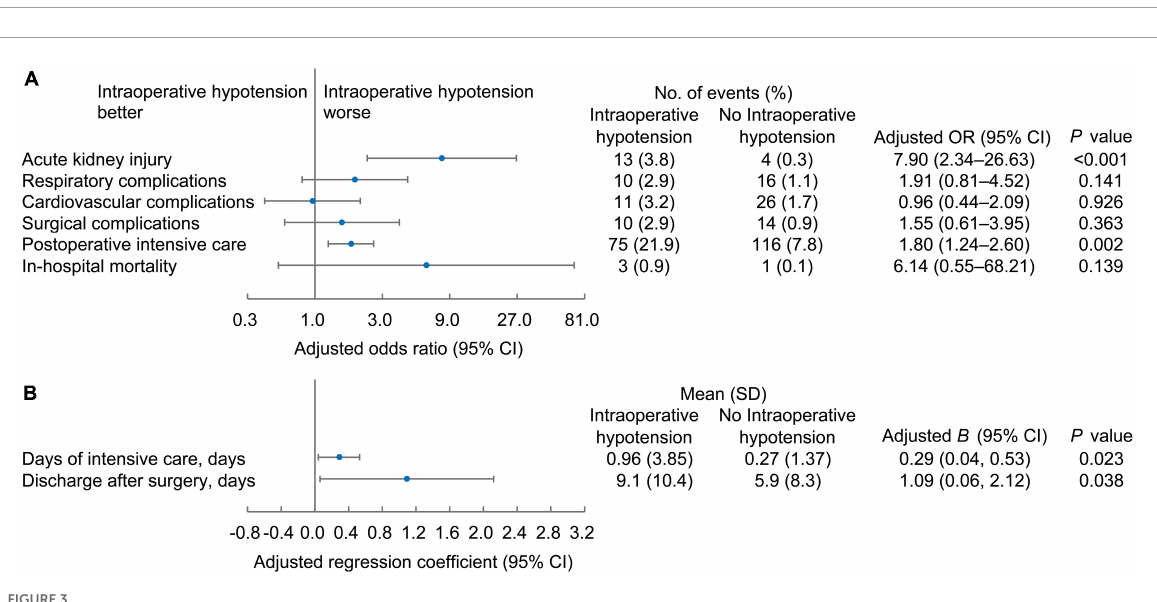
frequently co-exists with comorbidities such as chronic kidney disease, diabetes, and hypercholesterolemia (26, 27), and hypertensive patients are more vulnerable to dysfunctional autonomic cardiovascular control (9) and